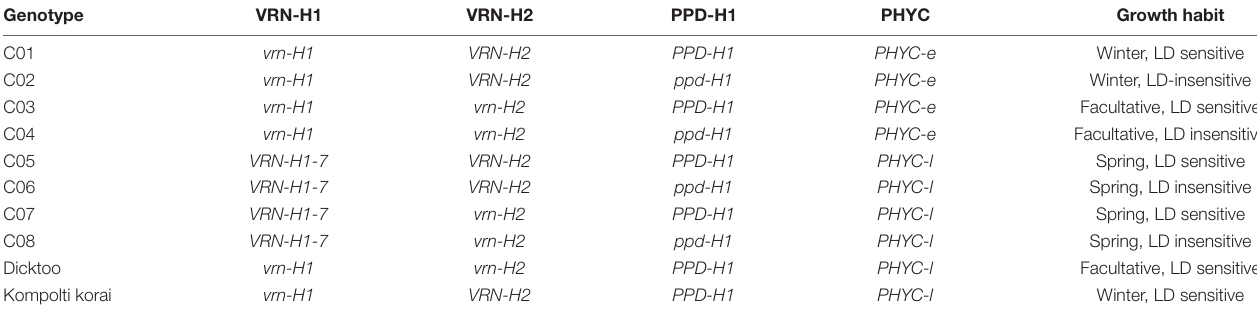
TABLE 1 | Genetic constitution of the barley genotypes analyzed in this study, at VRN-H1 , VRN-H2 , PPD-H1 and PHYC, and growth habit.